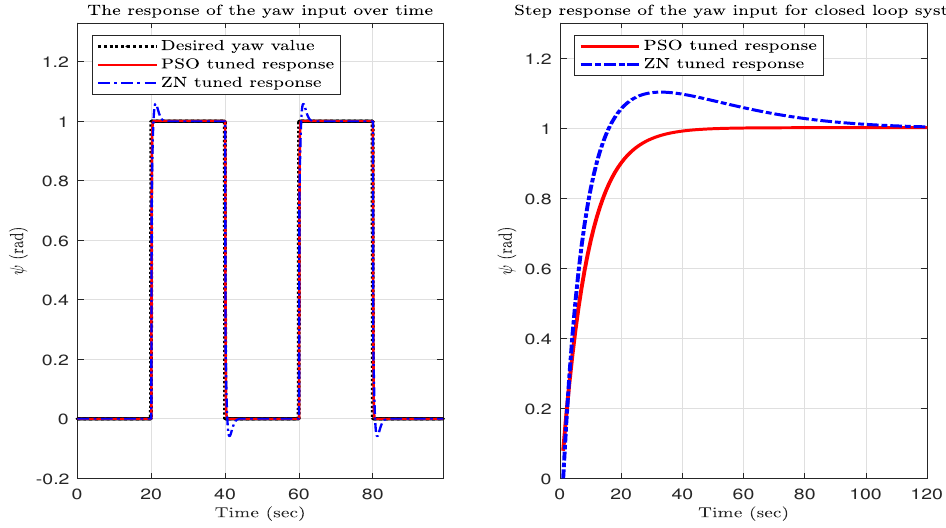
Figure 13. Simulated output responses of the yaw input of a quadcopter using PSO and ZN